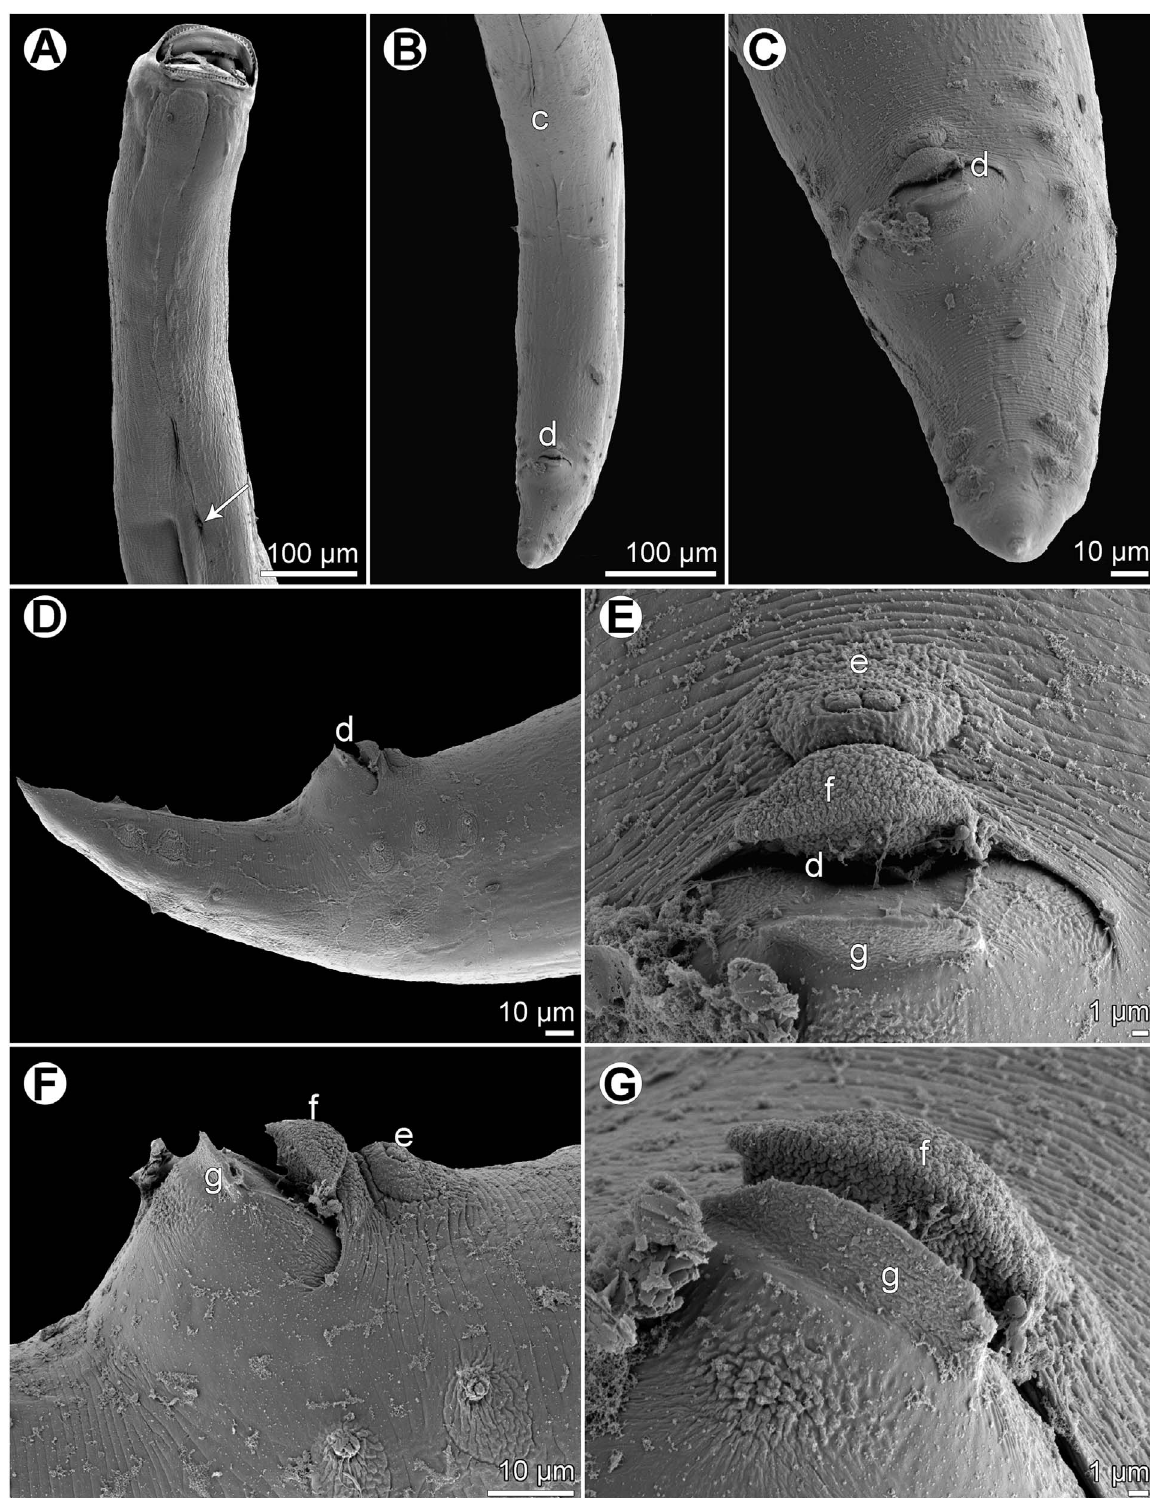
Figure 13. Cucullanus petterae n. sp. n., scanning electron micrographs of male from Epinephelus merra . (A) Anterior end, lateral view (arrow indicates deirid); (B) posterior end, ventral view; (C) tail, ventral view; (D) tail, lateral view; (E, F) region of cloaca, ventral and lateral views, respectively; (G) cloaca, sublateral view. (c) Ventral sucker; (d) cloacal aperture; (e) precloacal median elevation containing two small papillae; (f) outgrowth of anterior cloacal lip; (g) outgrowth of posterior cloacal